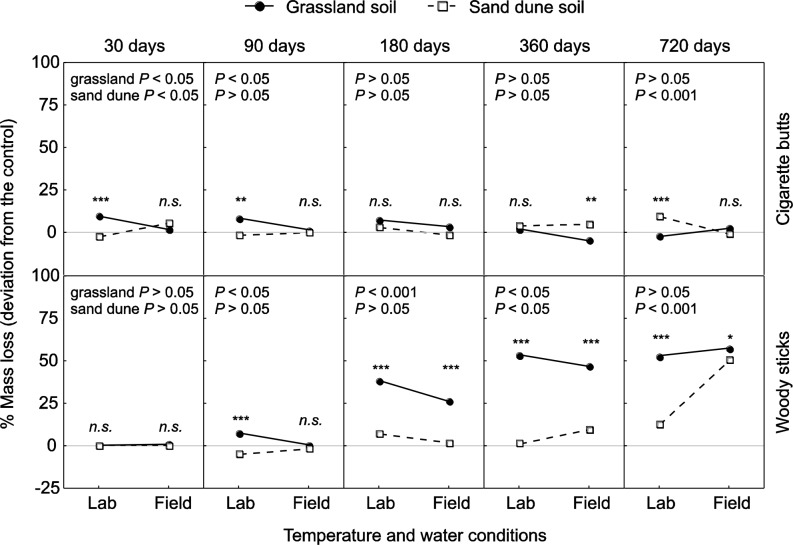
Interactive effects of environment conditions on mass loss.Interactive effects of environment-related parameters on percent mass loss of the tested materials (CBs, top panel row, and wood sticks, bottom panel row) at different decomposition stages (from 30 to 720 days, panel columns). On each graph, P-values in the top-left corner refer to the effects of temperature and water treatment (controlled in the laboratory, natural conditions in the field) on samples incubated with either grassland or sand dune soil. Stars above symbols refer to the effects of soil type within each temperature and water treatment (***: P < 0.001, **: P < 0.01, *: P < 0.05, n.s.: P > 0.05). All statistical results refer to post-hoc Duncan tests from GLM in S1 Table.